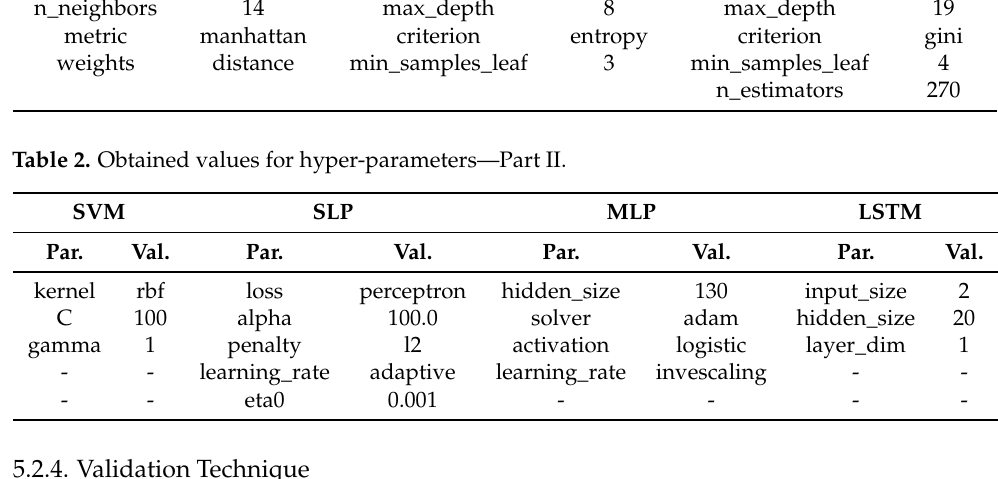
Table 1. Obtained values for hyper-parameters—Part I. KNN DT RF Parameter Value Parameter Value Parameter Value